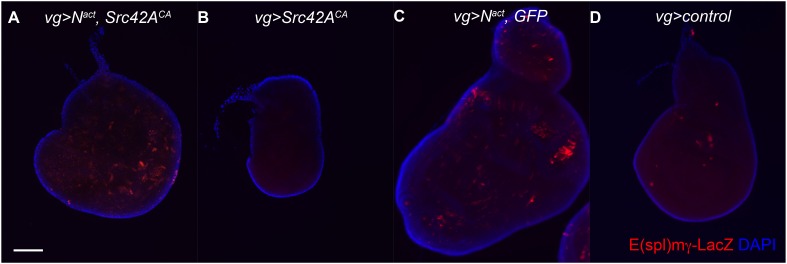
E(spl)mγ reporter staining in N/Src wing discs.VgGal4 wing discs expressing UAS-Nact and/or UAS-Src42ACA in an E(spl)mγ-LacZ/+ background were stained for anti-β-gal. E(spl)mγ-LacZ consists of the 234-bp mγ enhancer region fused to a LacZ reporter (Nellesen et al., 1999). Note that E(spl)mγ induced by Nact (C) is not suppressed by the addition of Src42ACA (A). Src42ACA alone (B) seems to suppress the endogenous E(spl)mγ staining (D) in the proneural cells.